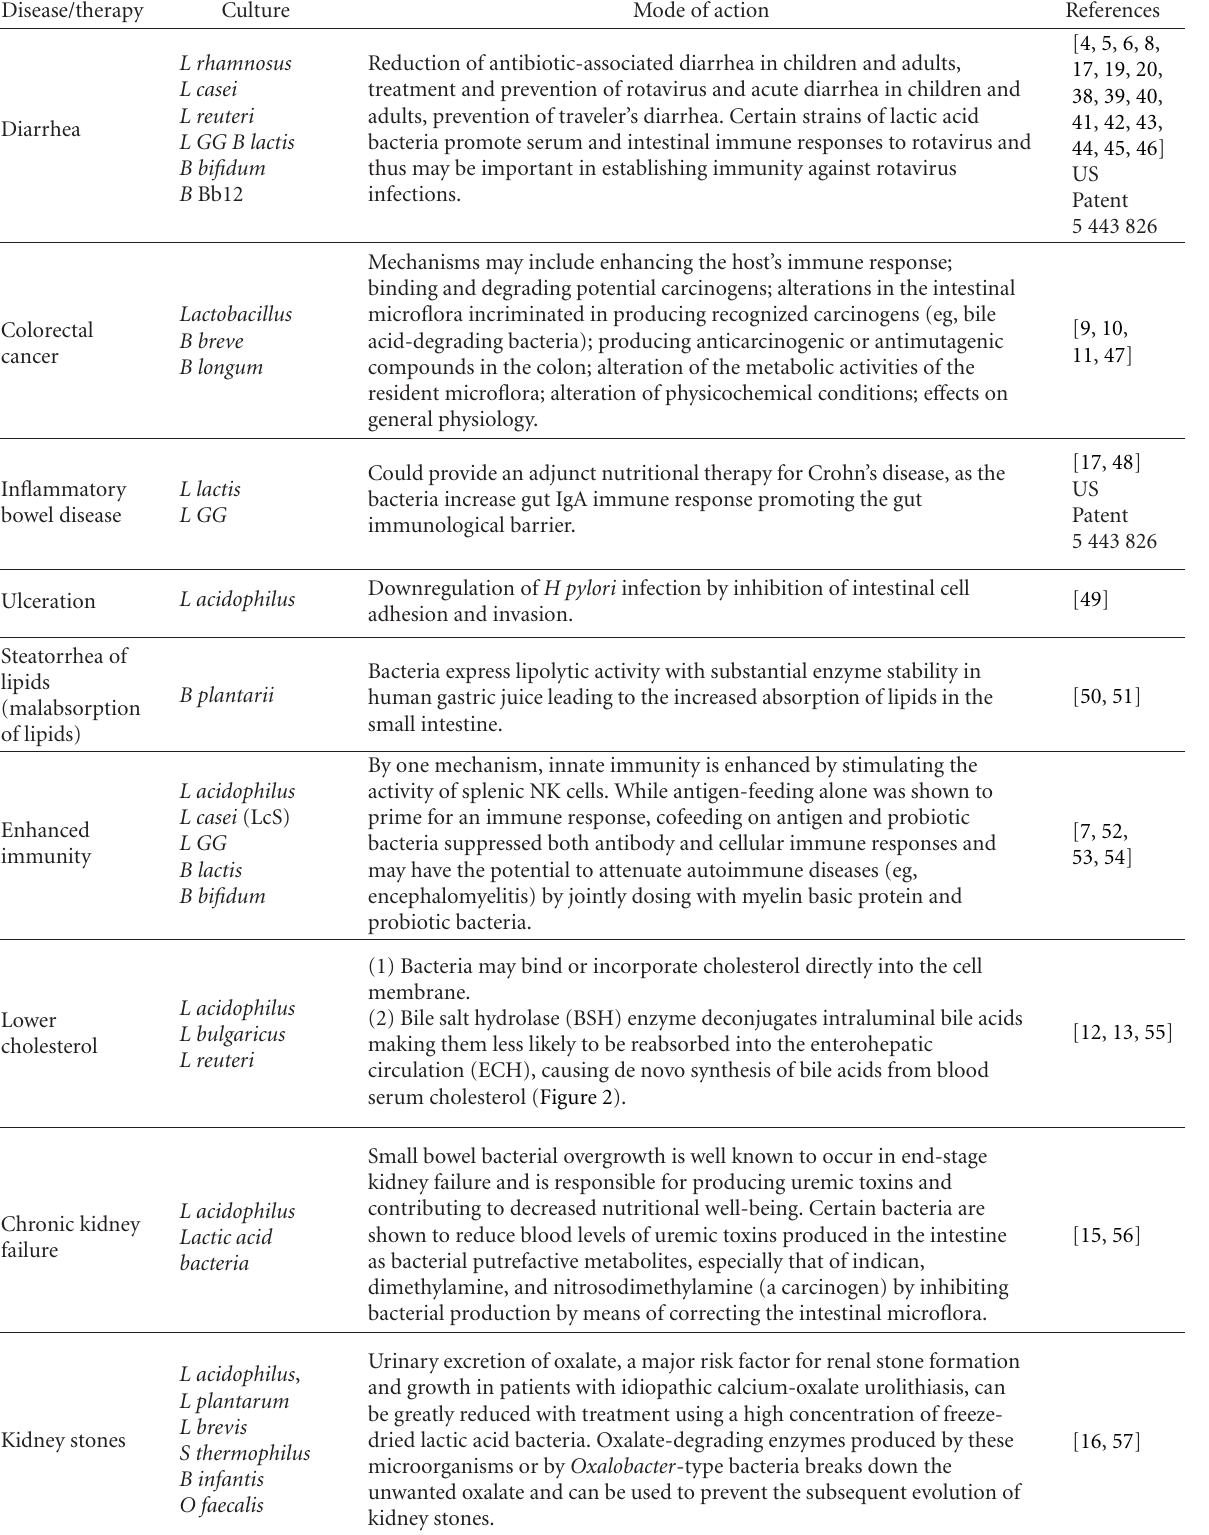
Table 1. Potential therapies based on the oral delivery of free live bacterial cells. Disease/therapy Culture Mode of